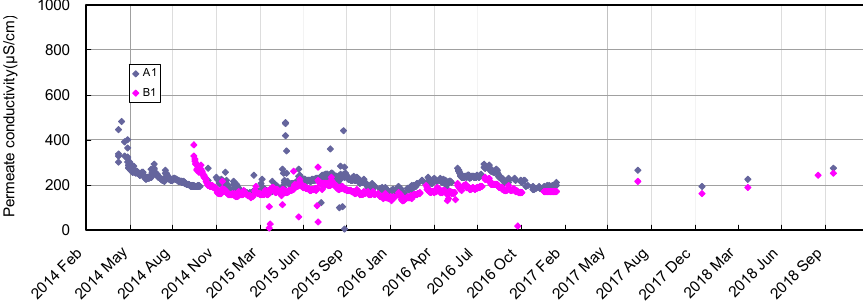
Figure 19. Seawater RO desalination system in the Ras Al Khair SWRO plant [95].